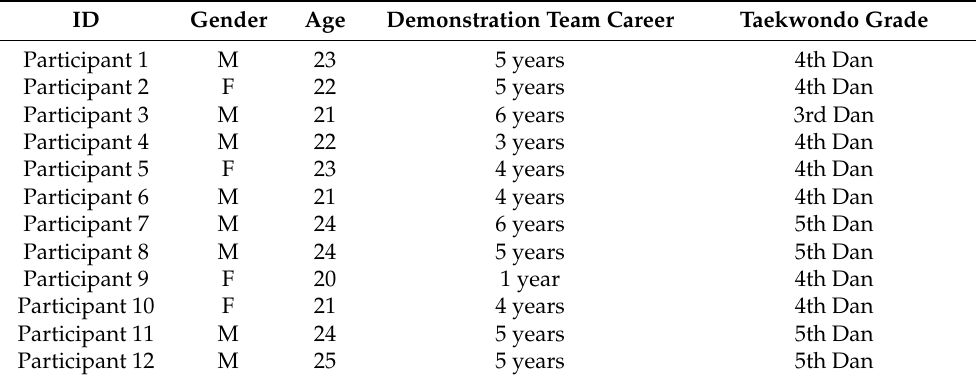
Table 1. Characteristics of